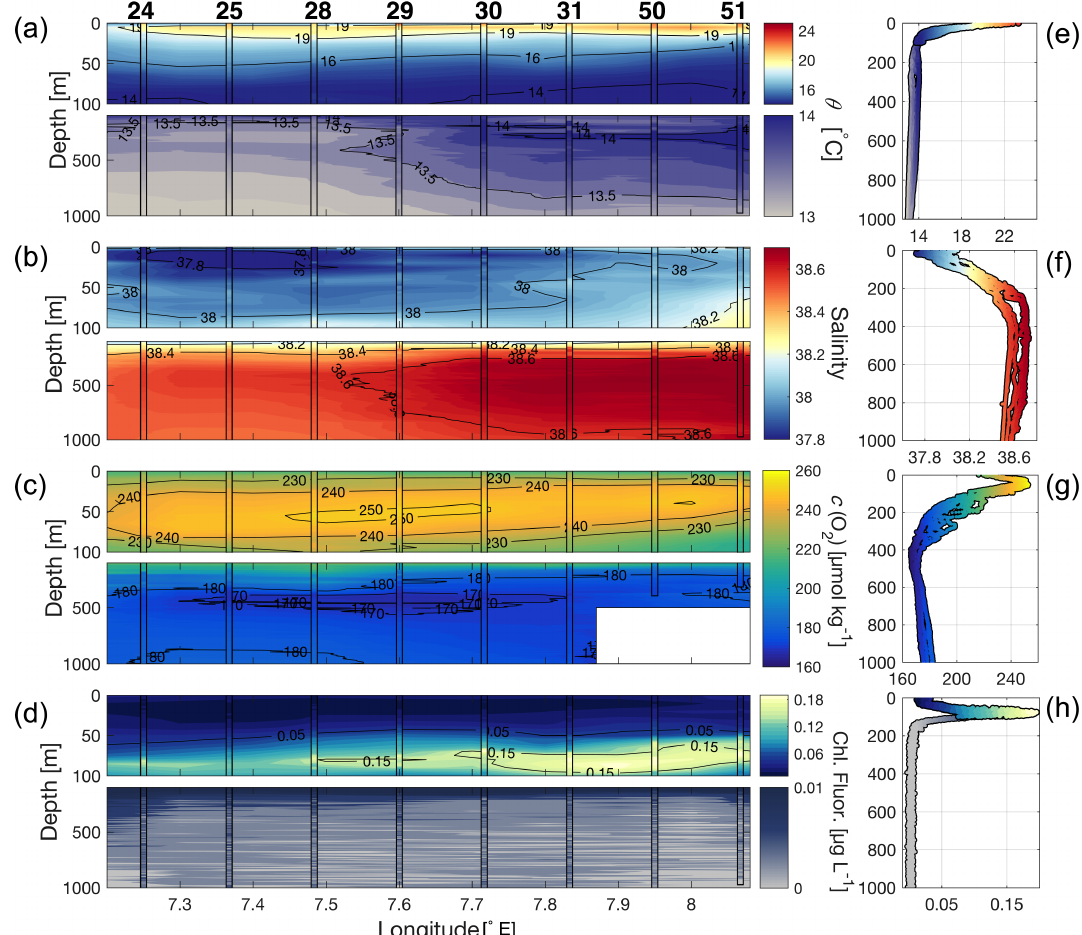
Figure 4. Transects of optimally interpolated (a) potential temperature ( θ ), (b) salinity, (c) dissolved oxygen concentrations ( c (O 2 )), and (d) chlorophyll fluorescence, along with their depth profiles (e–h) obtained by ship. These parameters were sorted into 0.1 ◦ longitude × 5m bins, and the radius of influence used for optimal interpolation was 0.2 ◦ longitude × 20m. The data retrieved during the eight CTD casts (displayed in Fig. 1) used for optimal interpolation are superimposed on the interpolated